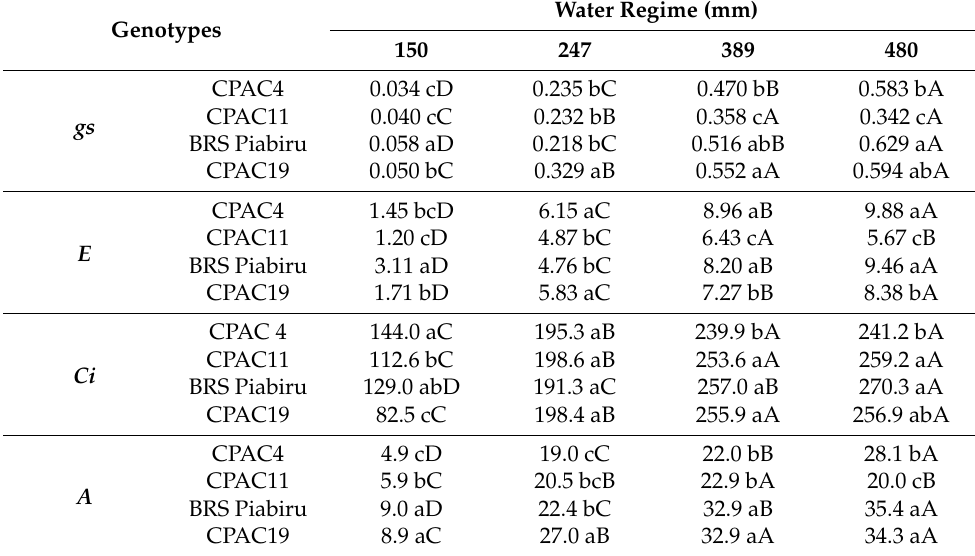
Table 5. Stomatal conductance ( g s –mol m − 2 s − 1 ), transpiration rate ( E –mmol m − 2 s − 1